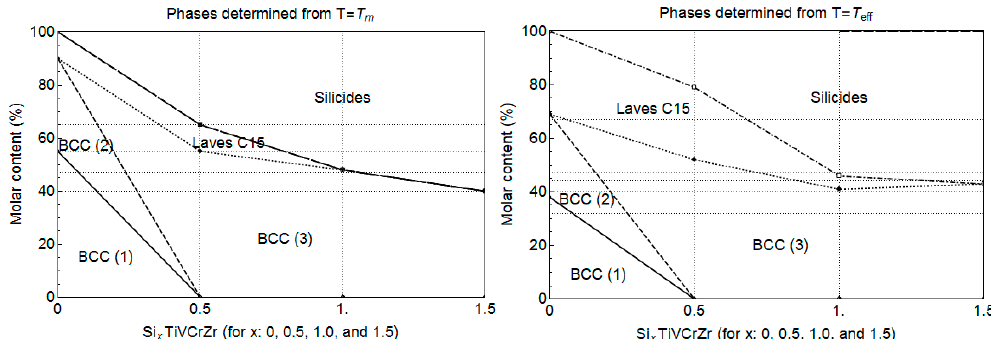
Figure 3. Predicted mole fractions of phases present in the alloys with different amounts of Si, determined from the property diagrams shown in Figure 2 at T = T m . All silicide phases are grouped together for the plot; Predicted mole fractions of phases present in the alloys are shown with different amounts of Si at T = T eff .